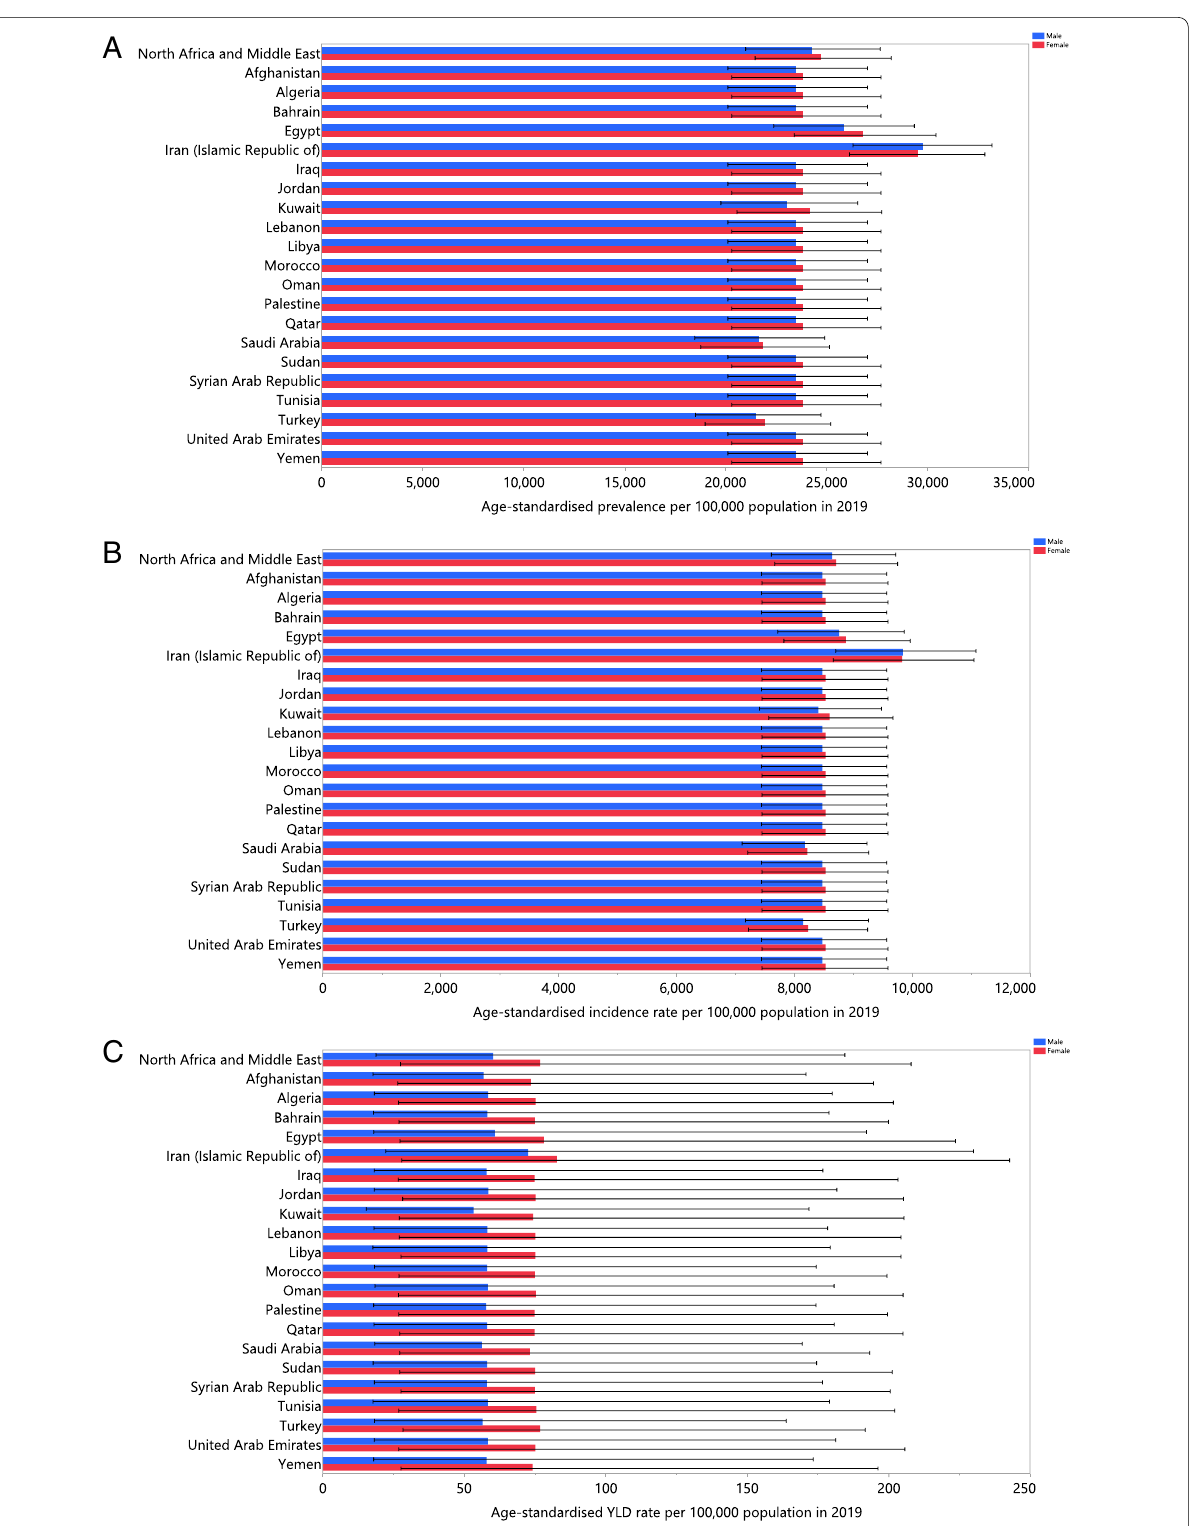
Fig. 1 Age‑standardised point prevalence ( A ), incidence ( B ), and YLDs ( C ) of tension‑type headache (per 100000 population) in the Middle East and North Africa region in 2019, by sex and country. YLD years lived with disability. (Generated from data available from http:// ghdx. healt hdata. org/ = gbd‑ resul ts‑